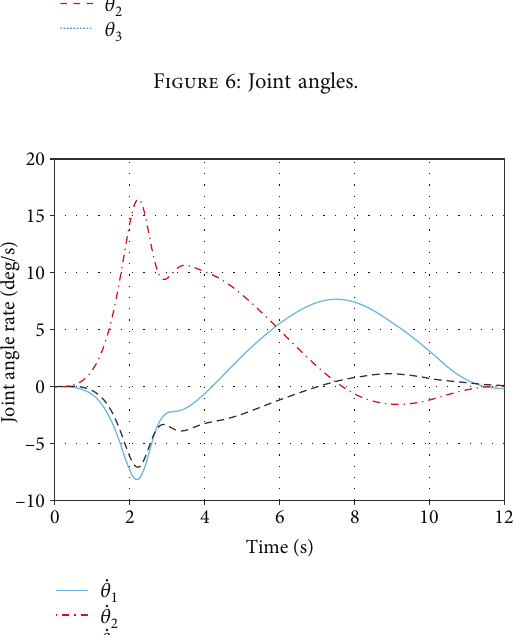
Figure 5: Joint control